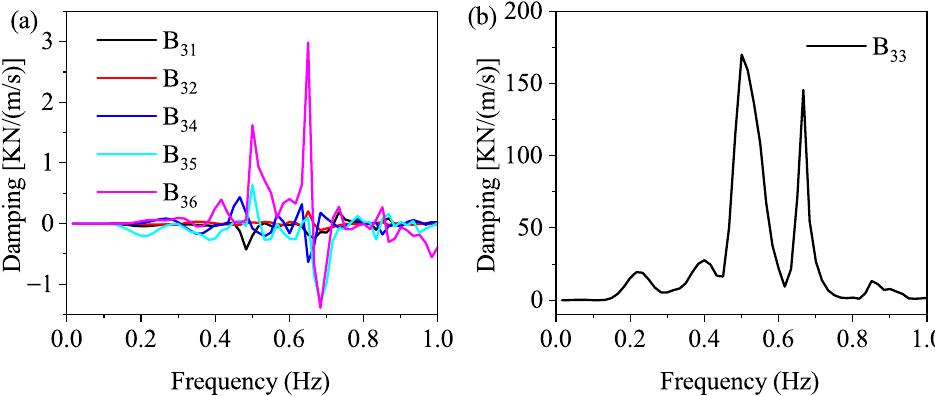
Figure 15. ( a ) The radiation damping coefficient B 31 , B 32 , B 34 , B 35 , B 36 ; ( b ) The radiation damping coefficient B 33